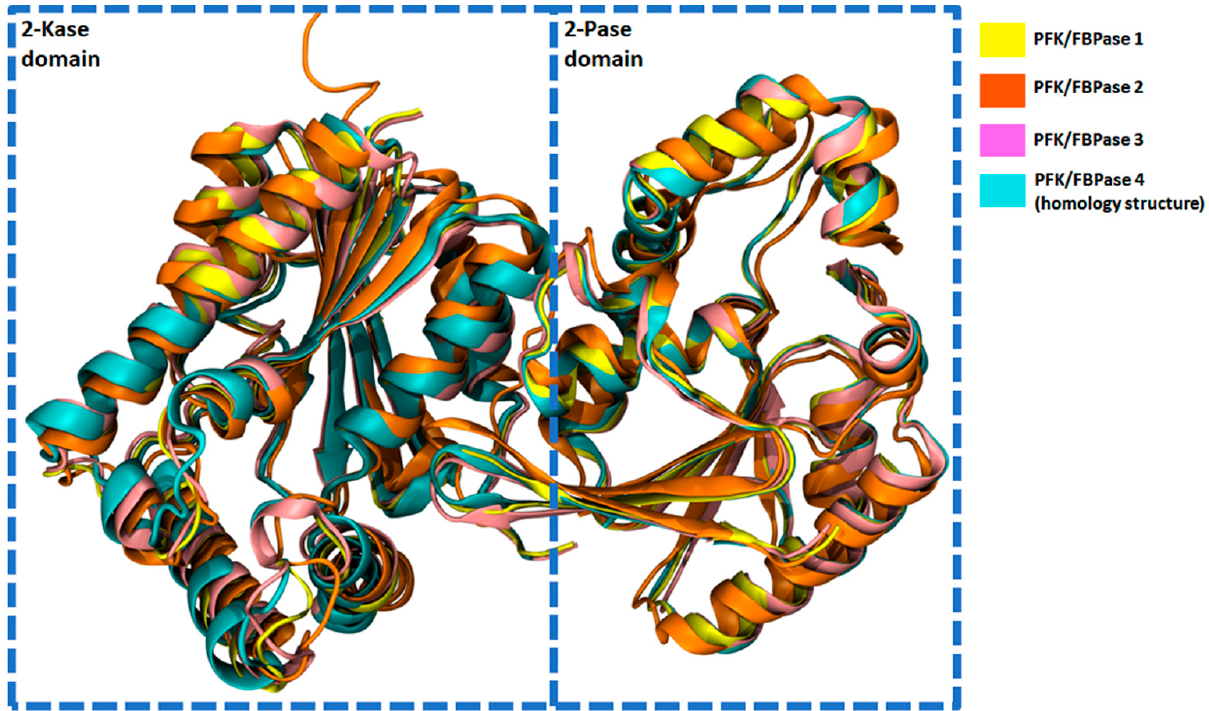
Figure 5. Superimposed structures of human PFKFB1 (yellow), PFKFB2 (orange), PFKFB3 (pink), and PFKFB4 (turquoise); the structures correspond to the sequences shown in Figure 3 and feature the 2-Kase domain (on the left) and 2-Pase domain (on the right). The structures were obtained from the Protein Data Bank (PDB) database [47] with the following codes: 1K6M (PFKFB1), 5HTK (PFKFB2), 6HVI (PFKFB3). The structure for human PFKFB4 was obtained using homology modeling with the Swiss-model [48]; the structure of rat ( Rattus norvegicus ) PFKFB4 (PDB Code 2BIF) shares the vast majority of the human sequence (>96%). The proteins were aligned using PyMol software [46] and the resulting structures were generated using visual molecular dynamics (VMD) software